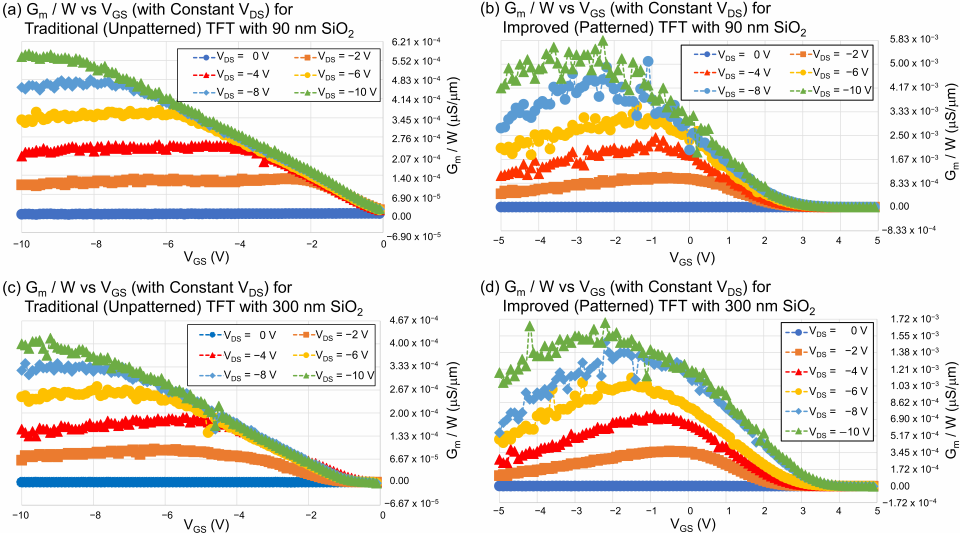
Figure 8. G m /W versus V GS characteristics (with constant V DS ) measured for the: ( a ) traditional (unpatterned) TFT with 90 nm SiO 2 , ( b ) improved (patterned) TFT with 90 nm SiO 2 , ( c ) traditional (unpatterned) TFT with 300 nm SiO 2 , and ( d ) improved (patterned) TFT with 300 nm SiO 2